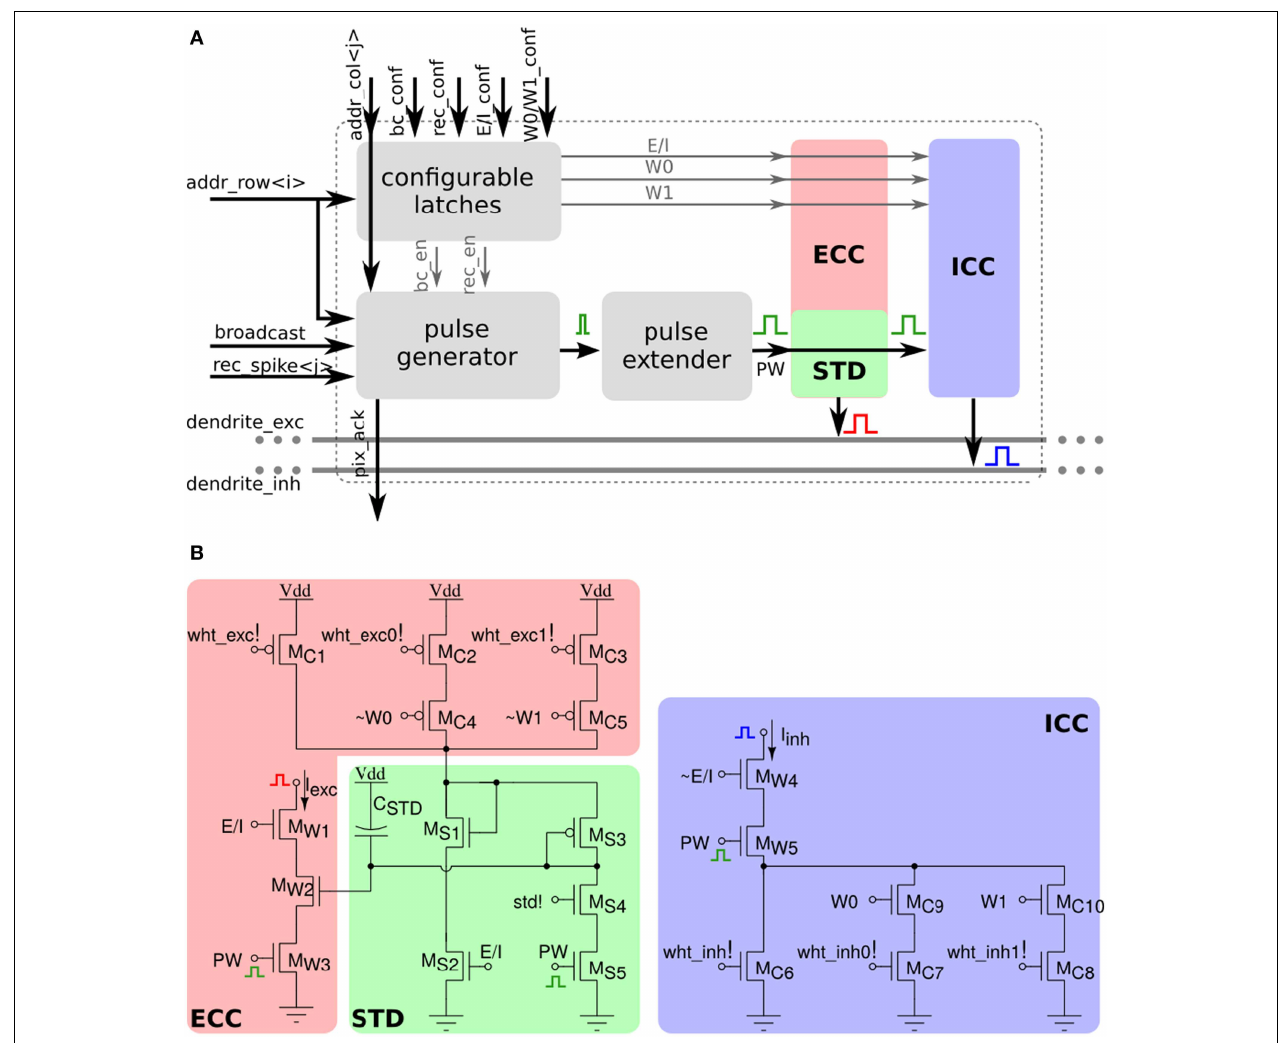
FIGURE 9 | Short-term plasticity synapse array element. (A) Block diagram of the synapse element. (B) Transistor level schematic diagram of the excitatory and inhibitory pulse-to-current